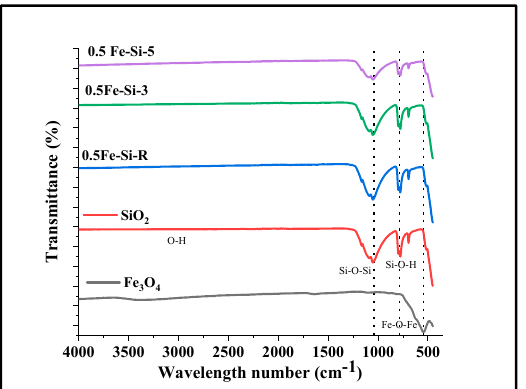
Figure 5. FTIR spectra of Fe 3 O 4 nanoparticles and related SiO 2 nanocomposites (raw and calcined at 300 °C and 500 °C).